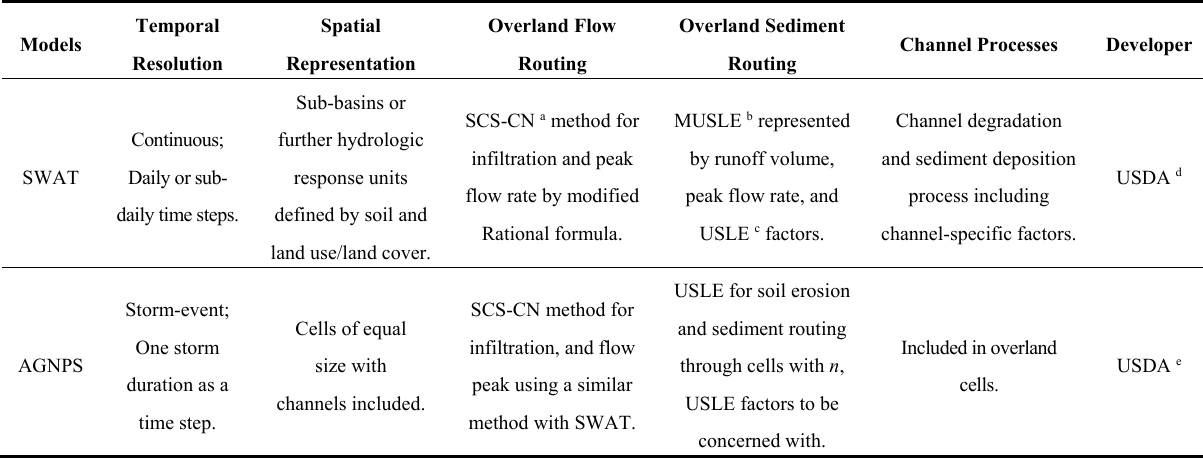
Table 2. Brief description of watershed models with respect to BMPs’